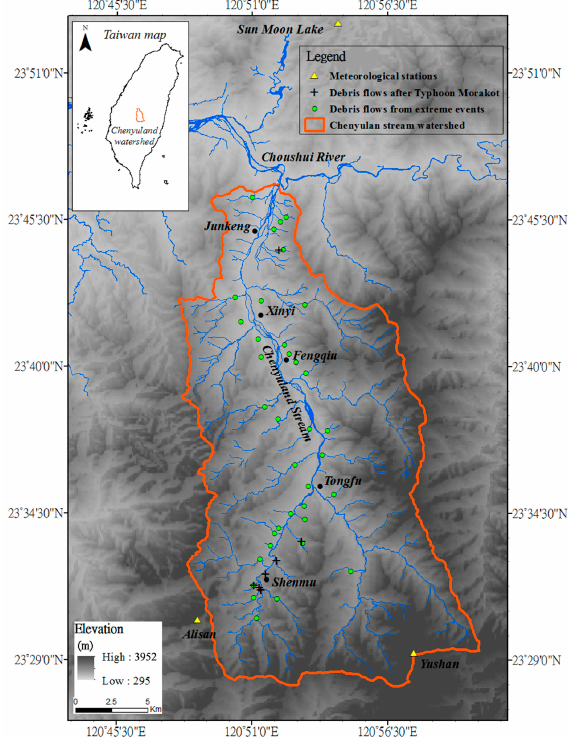
Figure 1. Map showing the study area in the Chenyulan watershed in central Taiwan, and locations of debris flows triggered by five extreme rainfall events (green circles), as well as recent debris flows (crosses) that occurred between 2009–2020 after the extreme event of Typhoon Morakot (TT) in 2009. The Chenyulan stream is a tributary of the Choushui River. The river is approximately 42 km long, the average stream bed gradient is 4 ◦ , and the watershed area is 449 km 2 with an elevation of 310–3952 m